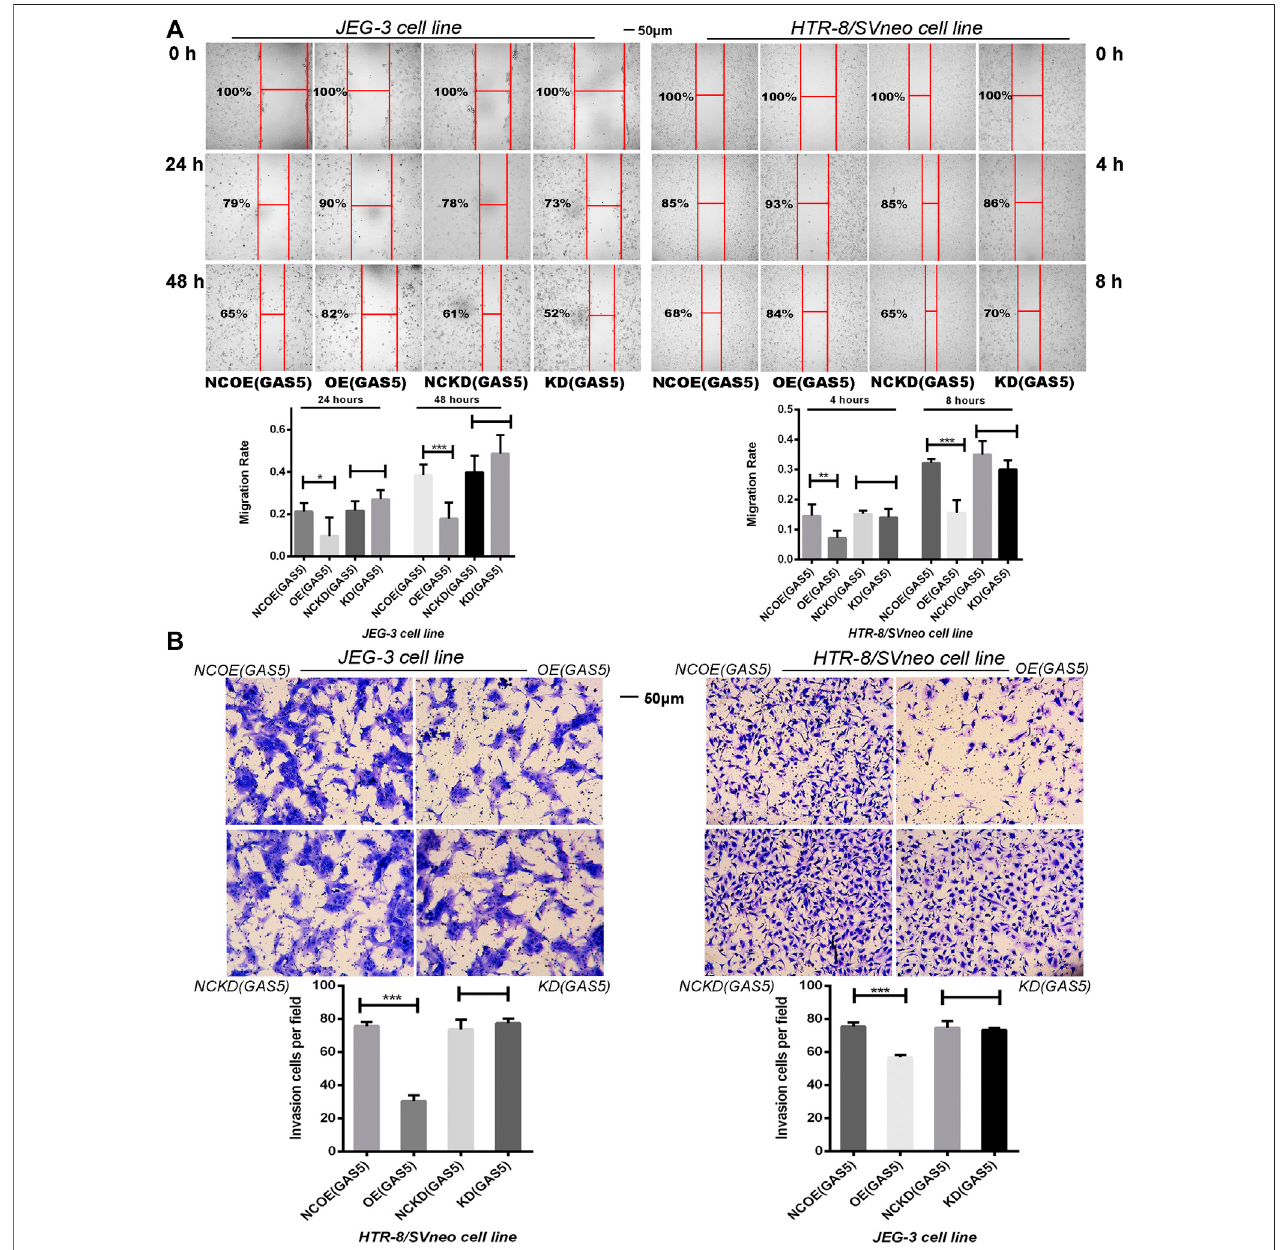
FIGURE 4 | (A) The Scratch test demonstrated the migration ability of two cell lines. Overexpression of GAS5 inhibited the migration of trophoblasts while knockdown GAS5 didn ’ t alter their migration ability. (B) Overexpression of GAS5 inhibited the invasion ability of trophoblasts according to transwell assay results, in the meanwhile, knockdown GAS5 didn ’ t alter their invation ability. * p < 0.05, ** p < 0.01, *** p < 0.001.